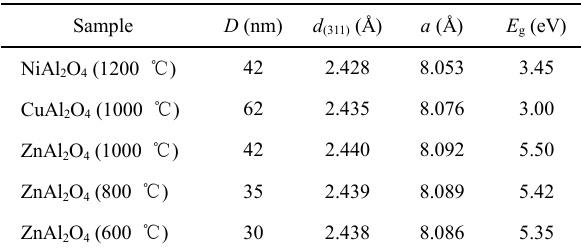
Average crystallite size ( D ), interplanar distance ( d ), lattice parameter ( a ), and band gap value ( E g ) of single-phase NiAl 2 O 4 , CuAl 2 O 4 , and ZnAl 2 O 4 powders Sample D (nm)